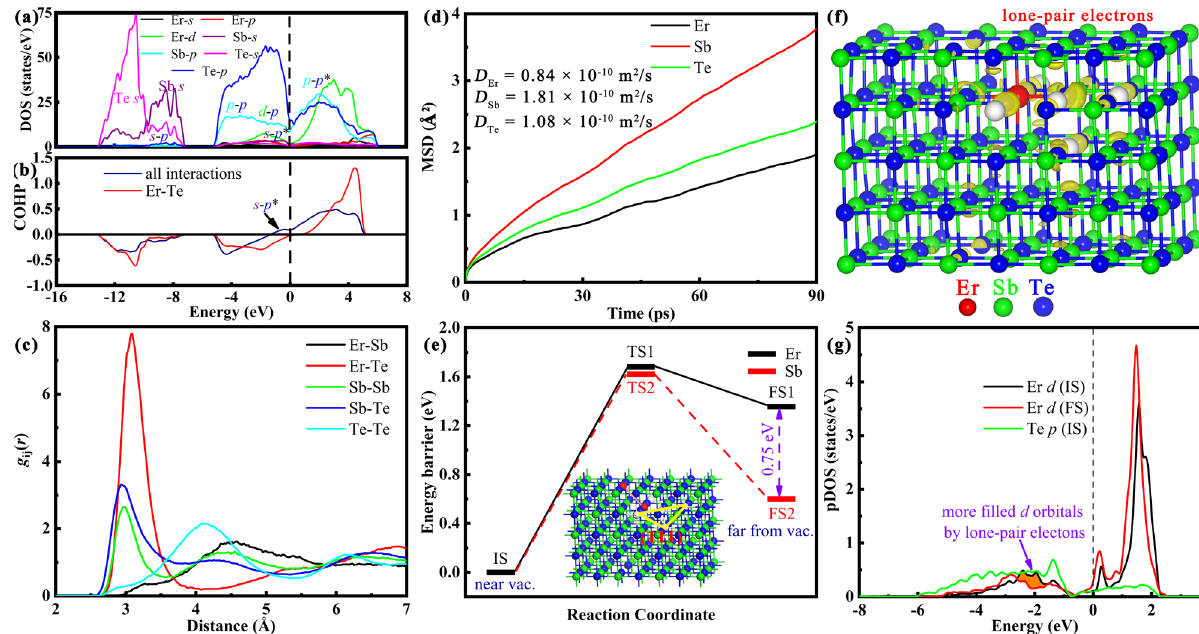
Fig. 4 Forming coorindate bonds by fi lling the empty 5d orbitals of Er atoms with the lone-pair electrons of Te atoms. It stabilizes both amorphous ( a – d ) and crystalline phases (e – g) . a The pDOS of Er, Sb, and Te atoms with various orbitals. b The COHP of average values of all interactions and Er − Te interaction, respectively. c The PCFs of Er − Sb (black), Er − Te (red), Sb − Sb (green), Sb − Te (blue), and Te − Te (cyan) pairs. d The MSDs for Er, Sb, and Te atoms. e The energetic pro fi le of diffusion barrier for Er (black) or Sb (red and dash), where a model with a four-vacancy-aggregated cluster in the (111) plane is shown in the inner graph. f The partial charge in the DOS region of [ − 3, 0] eV in the IS structure, where 3D isosurface value is set as 0.2 eÅ − 3 . g The partial DOS of Er d (black) and Te p (green) orbitals in the IS structure, while the Er d (red) orbital in the FS structure also shown for comparison. It is noted that the pDOS of Te p orbitals is divided by Te number (48